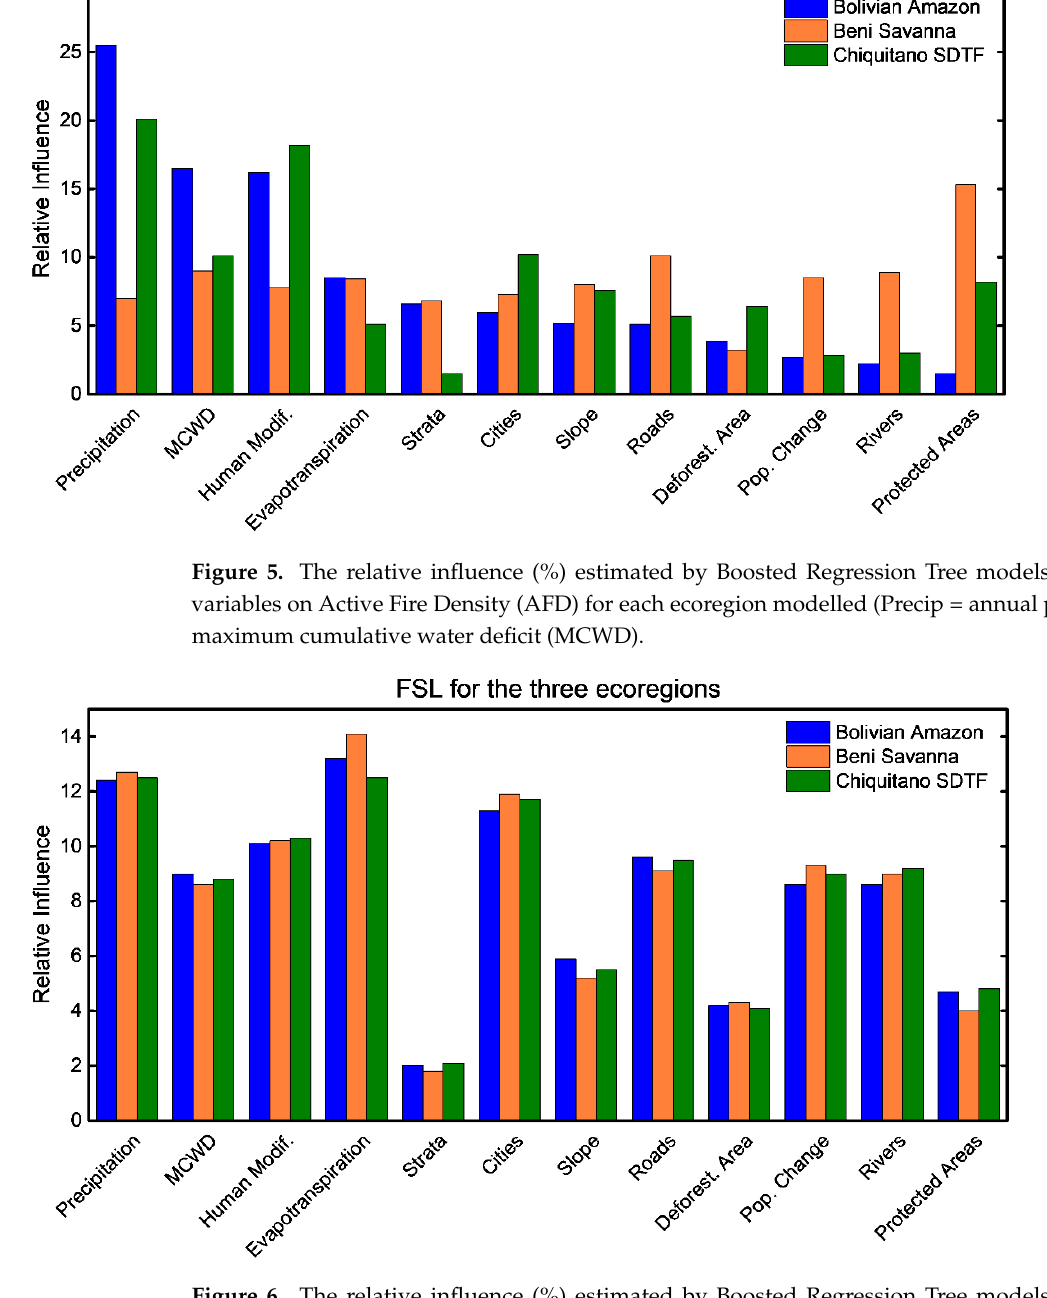
Figure 6. The relative influence (%) estimated by Boosted Regression Tree models of different vari- ables on Fire Season Length (FSL) for each ecoregion modelled (abbreviations as per Figure 5).